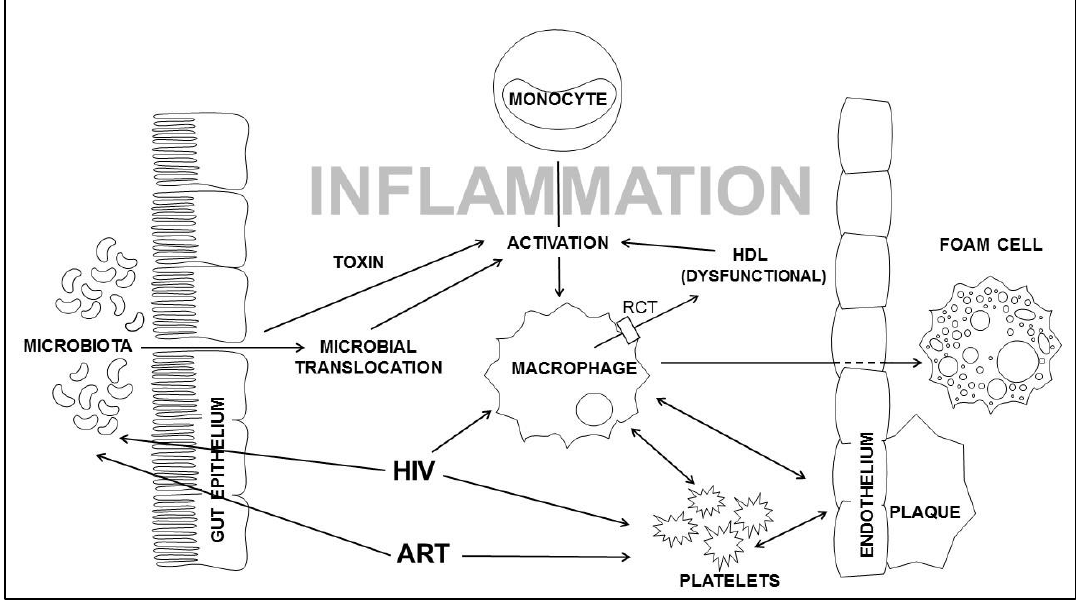
Figure 2. Inflammation and innate immune activation contribute to pathogenesis of CVD in PLWH.